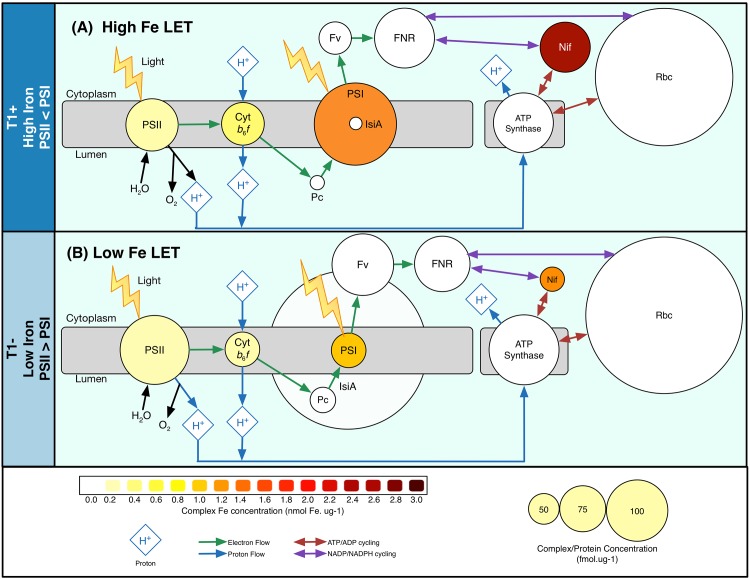
Linear electron flow schematic during high and low Fe conditions.Simplified schematic demonstrating the linear electron transport pathway during both high Fe (A, T1+) and low Fe (B, T1-) conditions. Protein complexes are shown as circles with their diameter indicative of observed complex concentration. Circles are coloured so as to show the predicted Fe concentration of that protein complex. Abbreviations include–PSII–photosystem II, Cyt b6f –Cytochrome b6f, PSI–photosystem I, Pc–plastocyanin, IsiA–iron stress induced protein A, Fv–Flavodoxin, FNR–Ferredoxin-NADP reductase, Rbc–RuBisCO, Nif–nitrogenase, ATP synthase–adenosine triphosphate synthase.